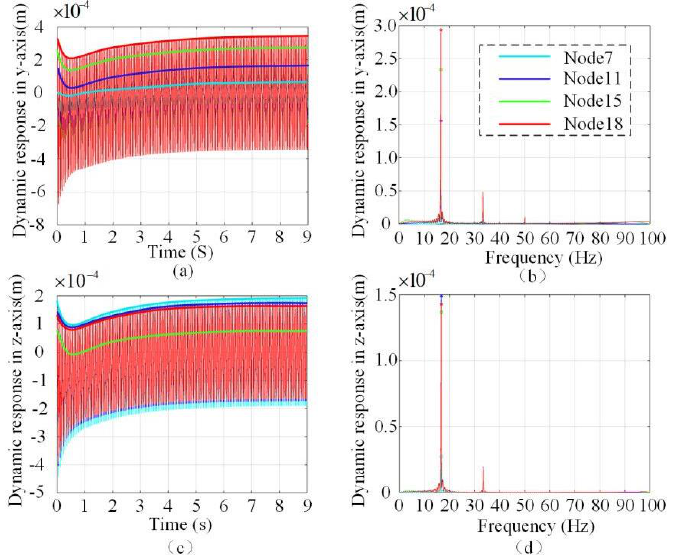
Figure 11. The dynamic response of GCRS with the bearing sti ff ness of 5 Nm. ( a ) The time domain dynamic response in the y -axis. ( b ) The frequency domain dynamic response in the y -axis. ( c ) The time domain dynamic response in the z -axis. ( d ) The time domain dynamic response in the z -axis.